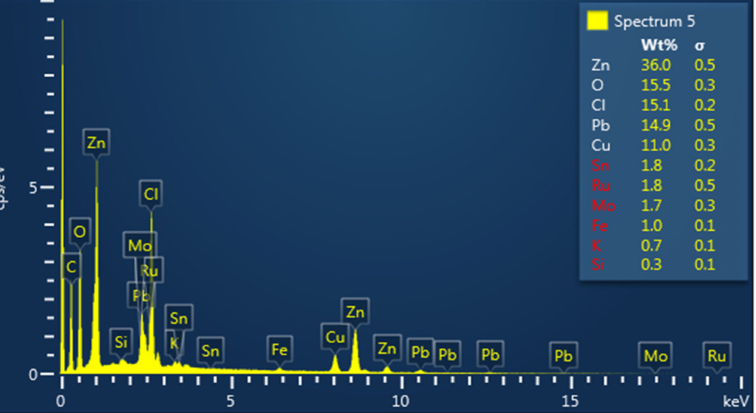
Figure 4. Scanning electron microscopy analysis along with energy dispersive spectrometry (SEM- EDX) analysis of Copper Anode Furnace dust